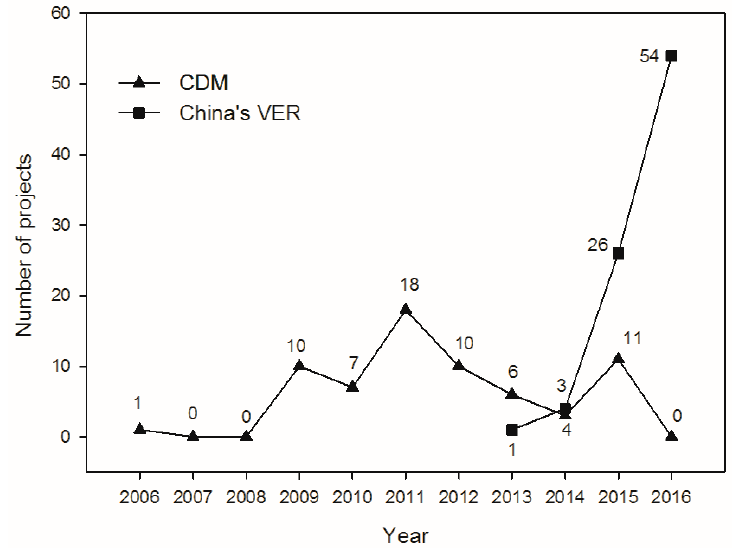
Figure 4. Number of validated CMD and China’s VER (Voluntary Emission Reduction) forest carbon projects. Table 3. Validated projects registered on the China Certified Emission Reduction Exchange info ‐ platform [34].